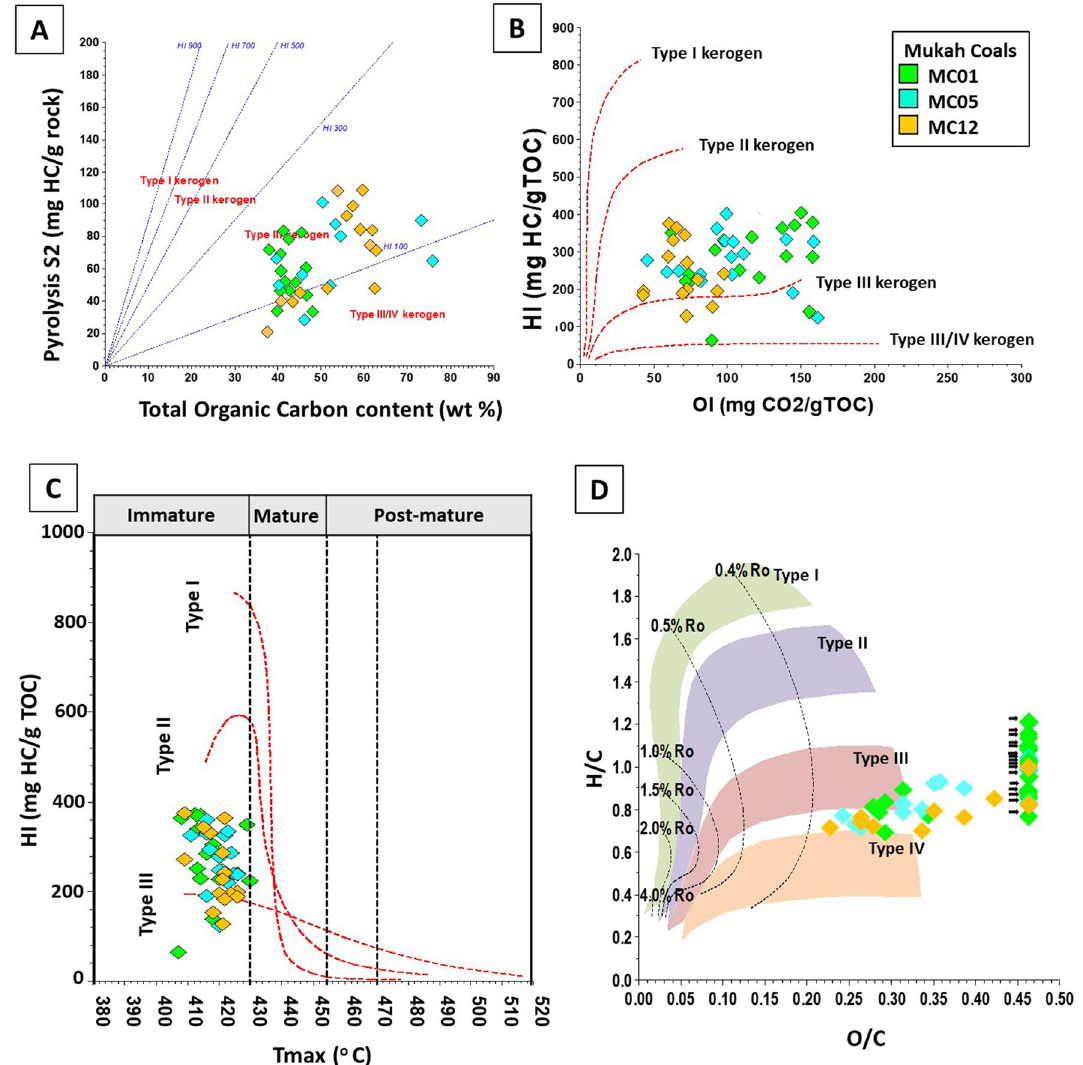
(HI) versus T max (°C), and ( D ) atomic ratios of H/C versus O/C ratios (modified after Van Krevelen, 1961), representing the kerogen types of the Mukah coals,